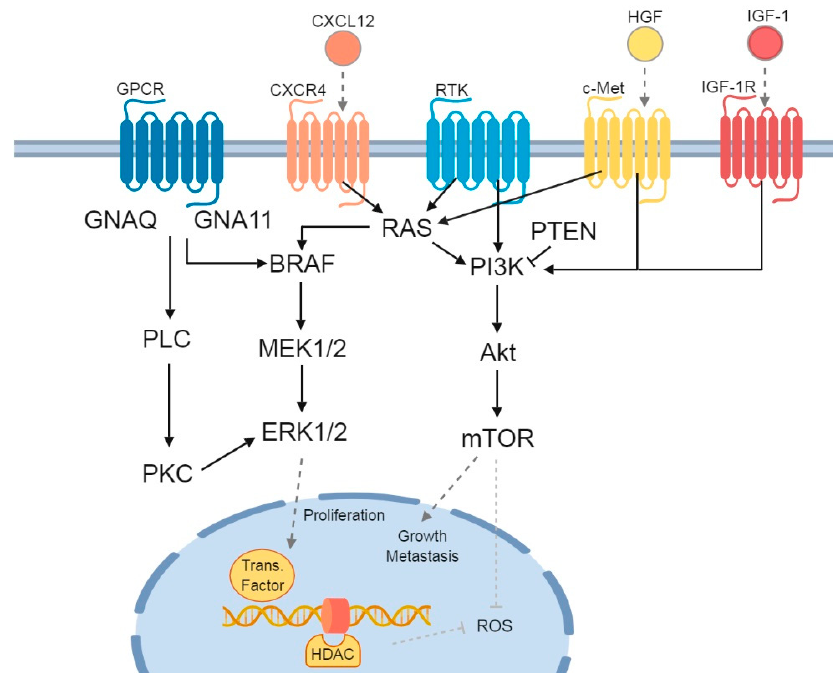
Figure 1. Signaling pathways and receptors involved in uveal melanoma (UM) and cutaneous melanoma (CM). Three main signaling pathways affected in UM and/or CM patients are depicted. G protein-coupled receptor (GPCR) with its Guanine nucleotide-binding proteins: the first is the Guanine nucleotide binding protein ( GNAQ ) and subunit alpha-11 ( GNA11 ), which downstream activate Phospholipase C (PLC) and Protein Kinase C (PKC). The second is the mitogen-activated protein kinase (MAPK) signaling pathway, consisting of BRAF-MEK1 / 2-ERK1 / 2 . Finally, there is the PI3K / Akt / mTOR pathway, which can be influenced by both RAS (from the MAPK signaling pathway) and phosphatase and tensin homolog (PTEN). The previously described chemokine receptors and their influence on the signaling pathways are added: C-X-C chemokine receptor 4 (CXCR4), with its C-X-C Motif Chemokine Ligand 12 (CXCL12), tyrosine-protein kinase Met (c-Met) and its ligand Hepatocyte Growth Factor (HGF), and Insulin-like Growth Factor-1 Receptor (IGF-1R), with Insulin-like Growth Factor-1 (IGF-1). In the nucleus, the ERK1 / 2 stimulates transcription factors, while both histone deacetylase (HDAC) and mechanistic target of rapamycin (mTOR) inhibit the formation of Reactive Oxygen Species (ROS). Figure was created with BioRender.com .